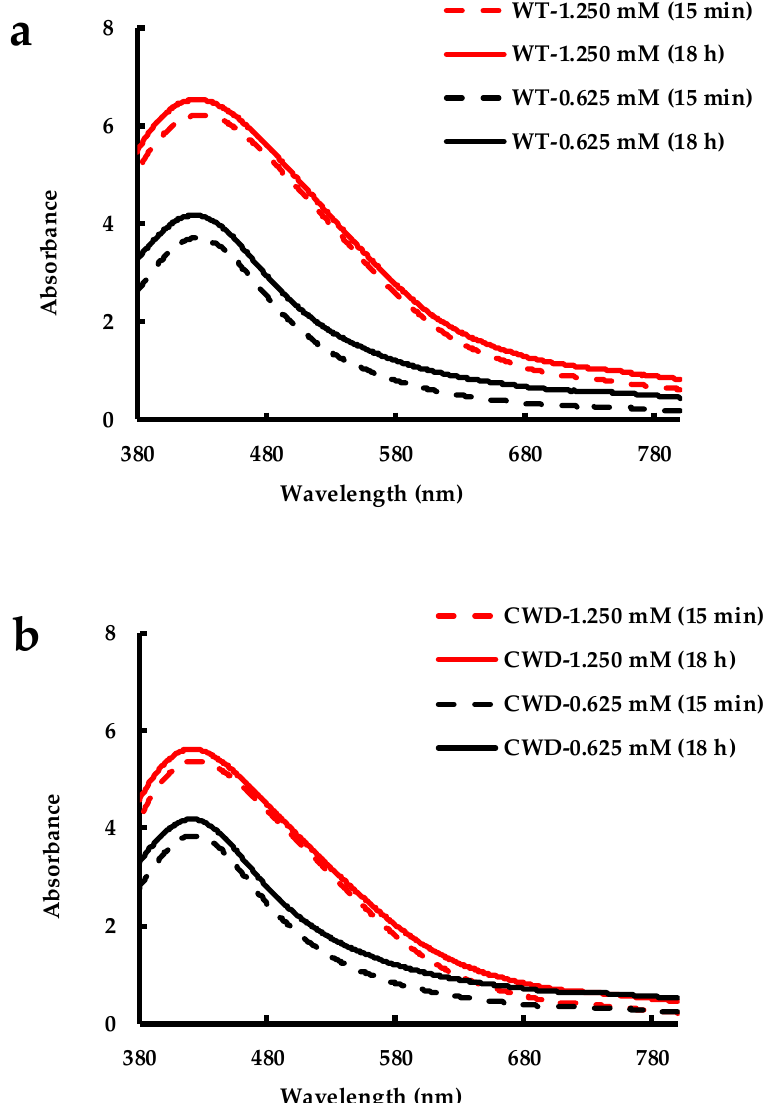
Figure 9. Stability in acetone of AgNPs produced by: ( a ) WT strain at 1.250 mM and 0.625 mM AgNO 3 concentrations; ( b ) CWD strain at 1.250 mM and 0.625 mM AgNO 3 concentrations.